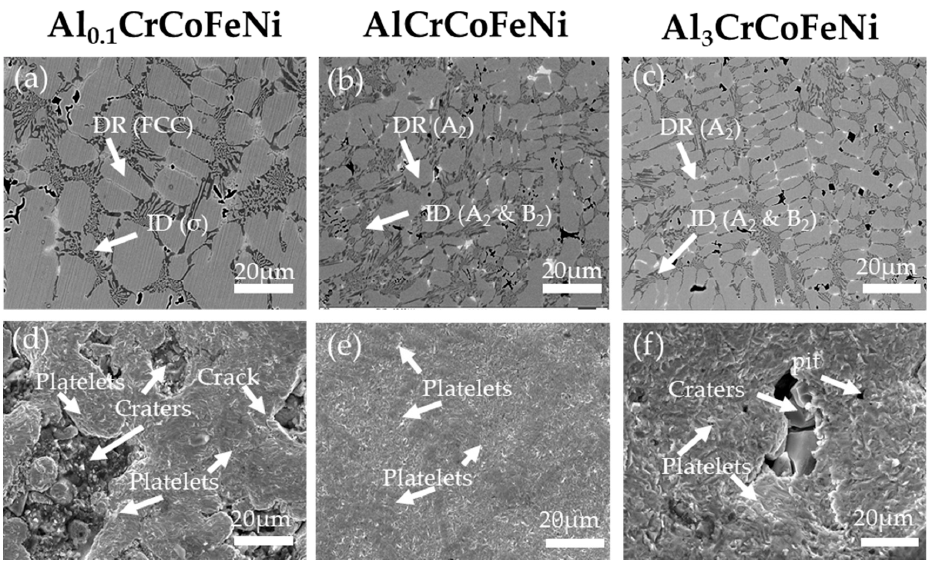
Figure 22. Microwave processed coatings of Al x CrCoFeNi high entropy alloys ( x = 0.1 to 3). ( a – c ) cellular microstructure of the synthesized coatings with dendrite region (DR) and inter dendrite region (ID); and, ( d – f ) microstructures after slurry erosion test at normal impingement angle (90°) for Al 0.1 CrCoFeNi, AlCrCoFeNi and Al 3 CrCoFeNi high entropy alloys [82].